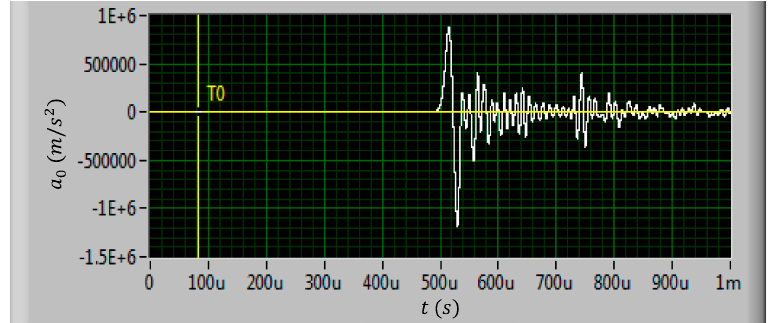
Figure 11. The measured 80,000 g shock load waveform. Micromachines 2020 , 11 , x